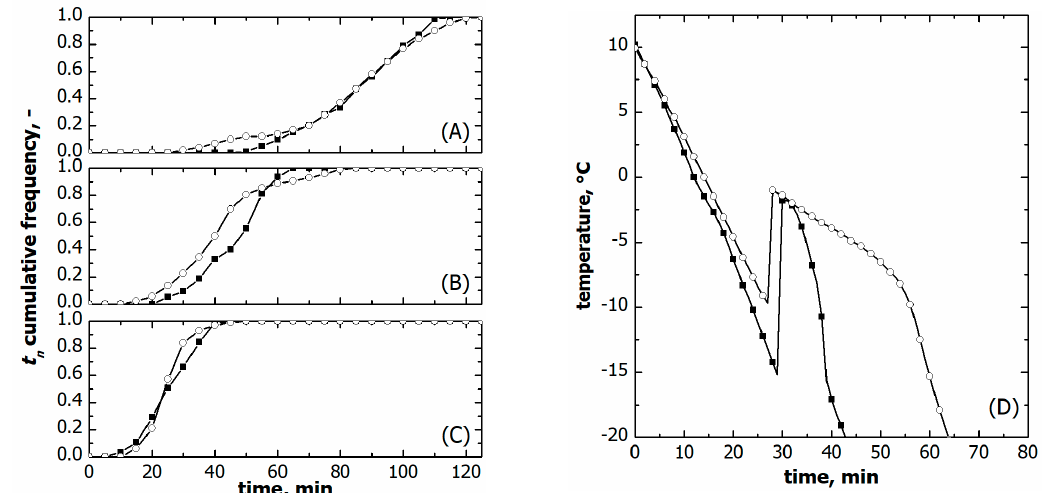
Figure 6. Comparison between cumulative ice nucleation time distributions of vials nested in a rack system ( ○ ) and in direct contact with the shelf ( ■ ). Data refer to various cooling rates: ( A ) 0.25, ( B ) 0.50, and ( C ) 1.00 °C min − 1 . ( D ) Comparison between the liquid temperature response during freezing in the case of vials nested in a rack system ( ○ ) and direct contact with the shelf ( ■ ). Data refer to a cooling rate of 1.00 °C min − 1 . The initial time was set as the instant at which thermocouples reached +10 °C.